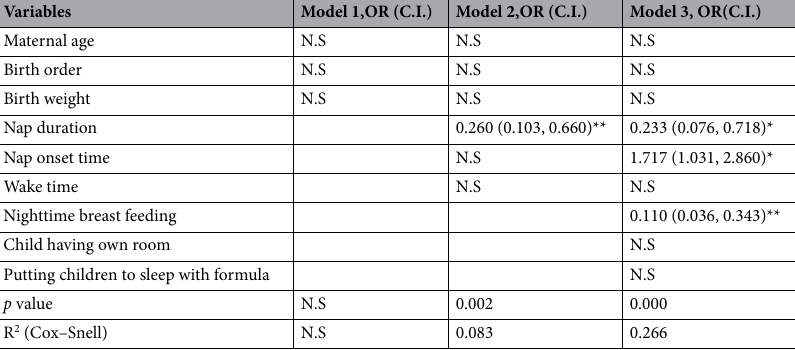
Table 5. Logistic regression of nighttime sleep of toddlers with gender/birth profiles, sleep variables, and sleep arrangement factors (OR, 95% CI ** p < 0.01, * p < 0.05).